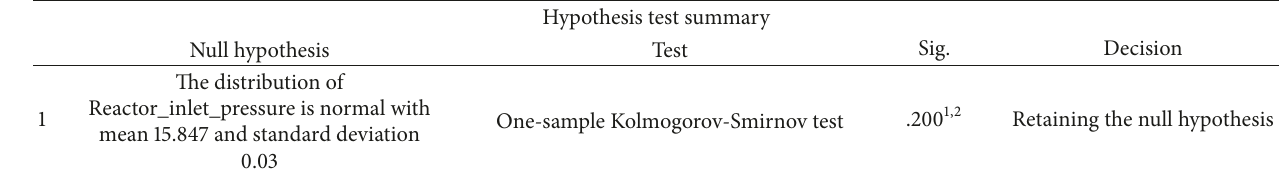
Table 6: Nonparametric tests summary of reactor inlet pressure.